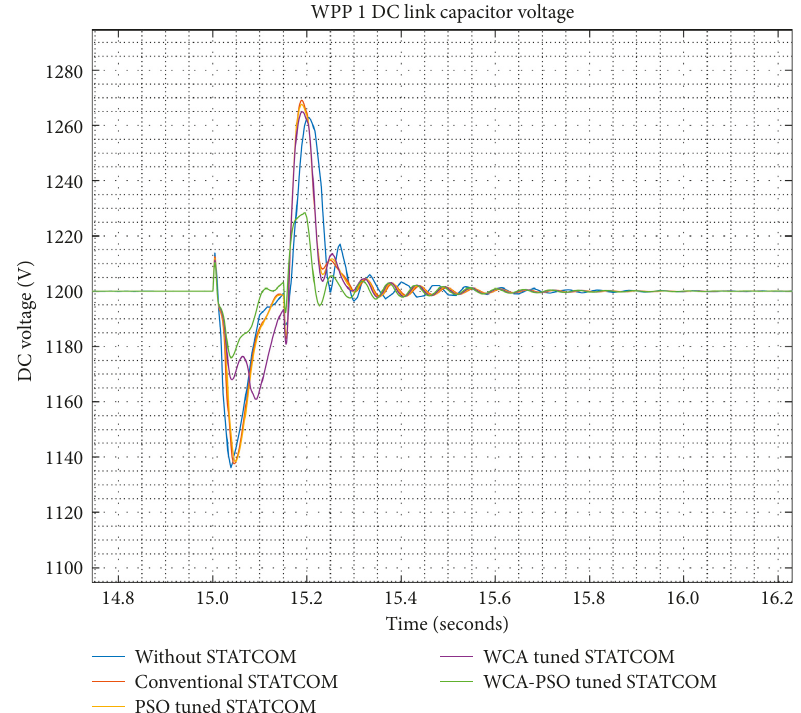
Figure 25: WPP 1 DC link capacitor voltage.